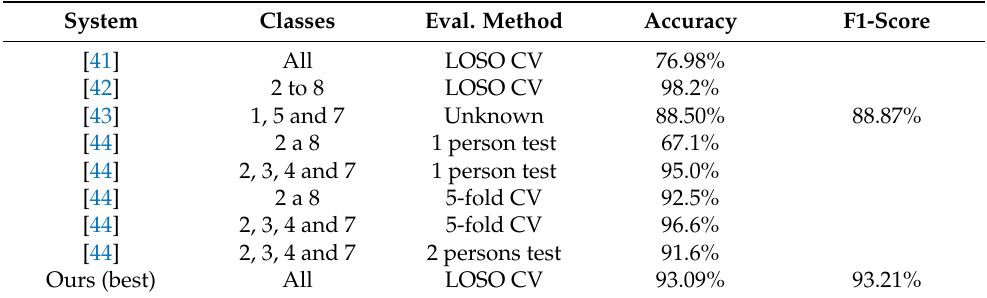
Table 11. Comparison of performance over BUHMAP against other published works.